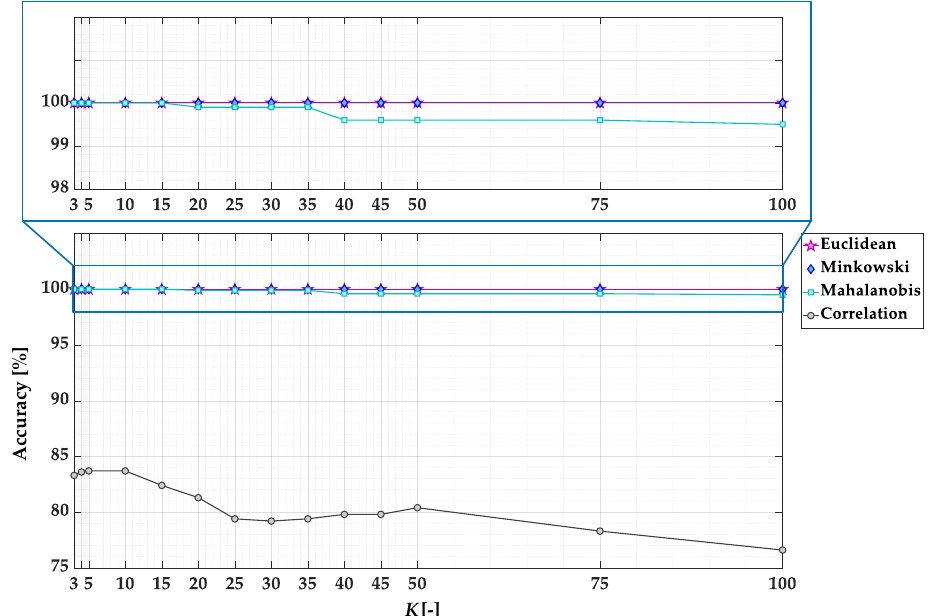
Figure 12. Accuracy of KNN-based PM fault detector model for different K values and distance metrics. Table 3. The KNN classifier accuracies for different key parameters.